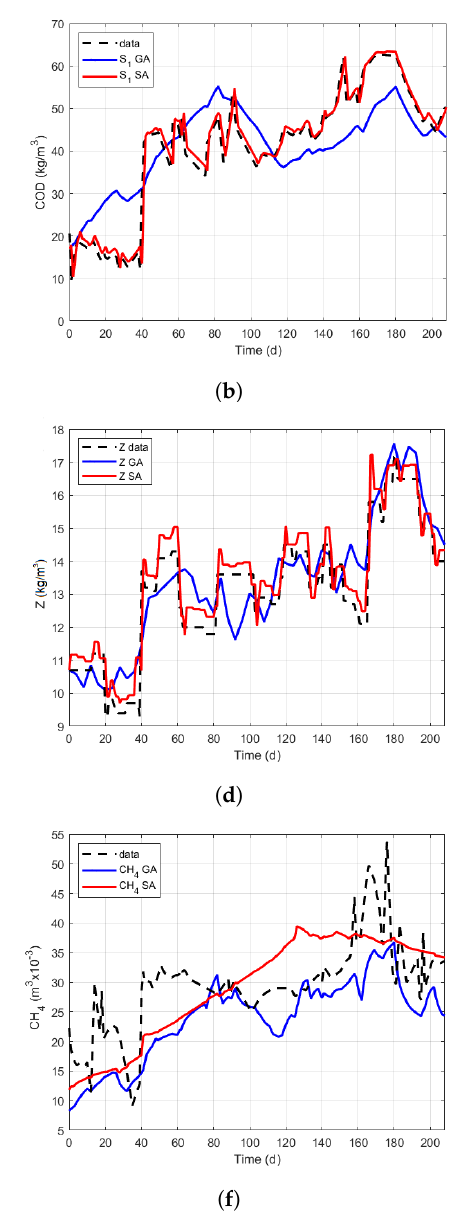
Figure 5. Use of genetic algorithm and step ahead algorithm to fit the mathematical model to the experimental data. ( a ) volatile fatty acids (VFA); ( b ) chemical oxygen demand (COD); ( c ) pH; ( d ) alkalinity ( Z ); ( e ) alkalinity at inlet ( Z in ); ( f ) CH 4 . Equation (41) was used to calculate the improvements achieved by the step-ahead algorithm over the genetic algorithm. The variables tested were VFA, COD, Z , pH, and CH 4 . The results are shown in Table 2. The best upgrading was obtained by VFA and COD with improvements of 78.7 and 60.5,